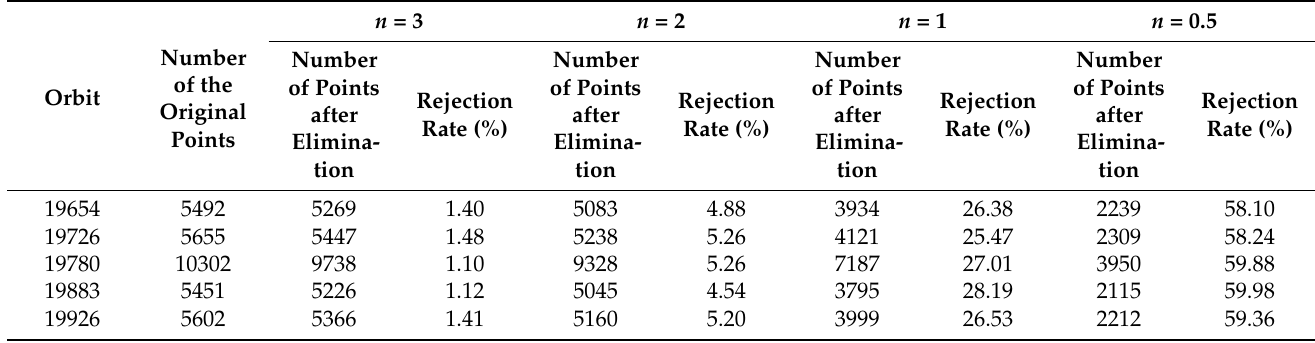
Figure 4. Outlier elimination results for different multiples of the standard deviation: ( a ) n = 3, ( b ) n = 2, ( c ) n = 1, ( d ) n = 0.5. Table 3. Rejection rates for different multiples of the standard deviation.